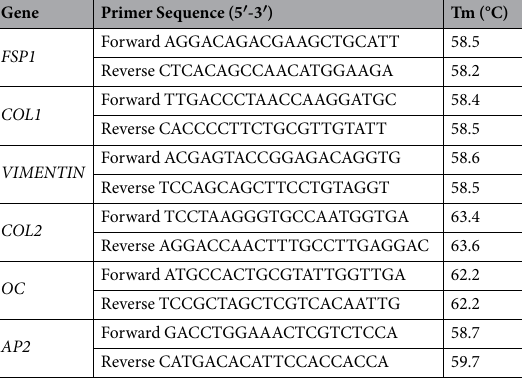
Table 1. Primers sequences used in the